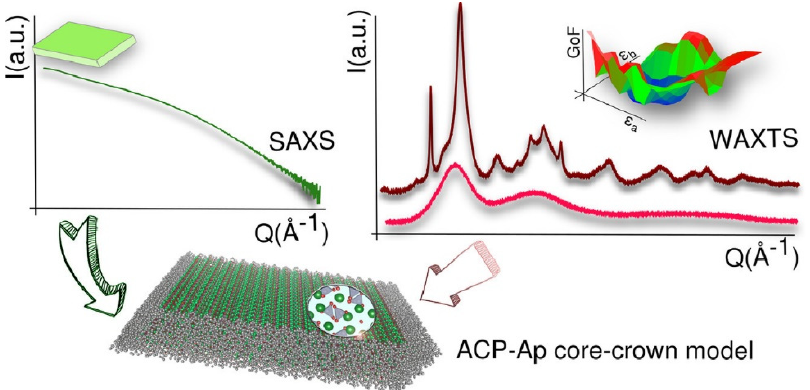
Figure 1. Schematic representation of the joint SAXS and WAXTS analysis used to elucidate the ACP-nAp core-crown arrangement of the nanocomposites platelets present in both biogenic and biomimetic apatite “Reprinted with permission from Ref. [17]. 2021, Elsevier”.